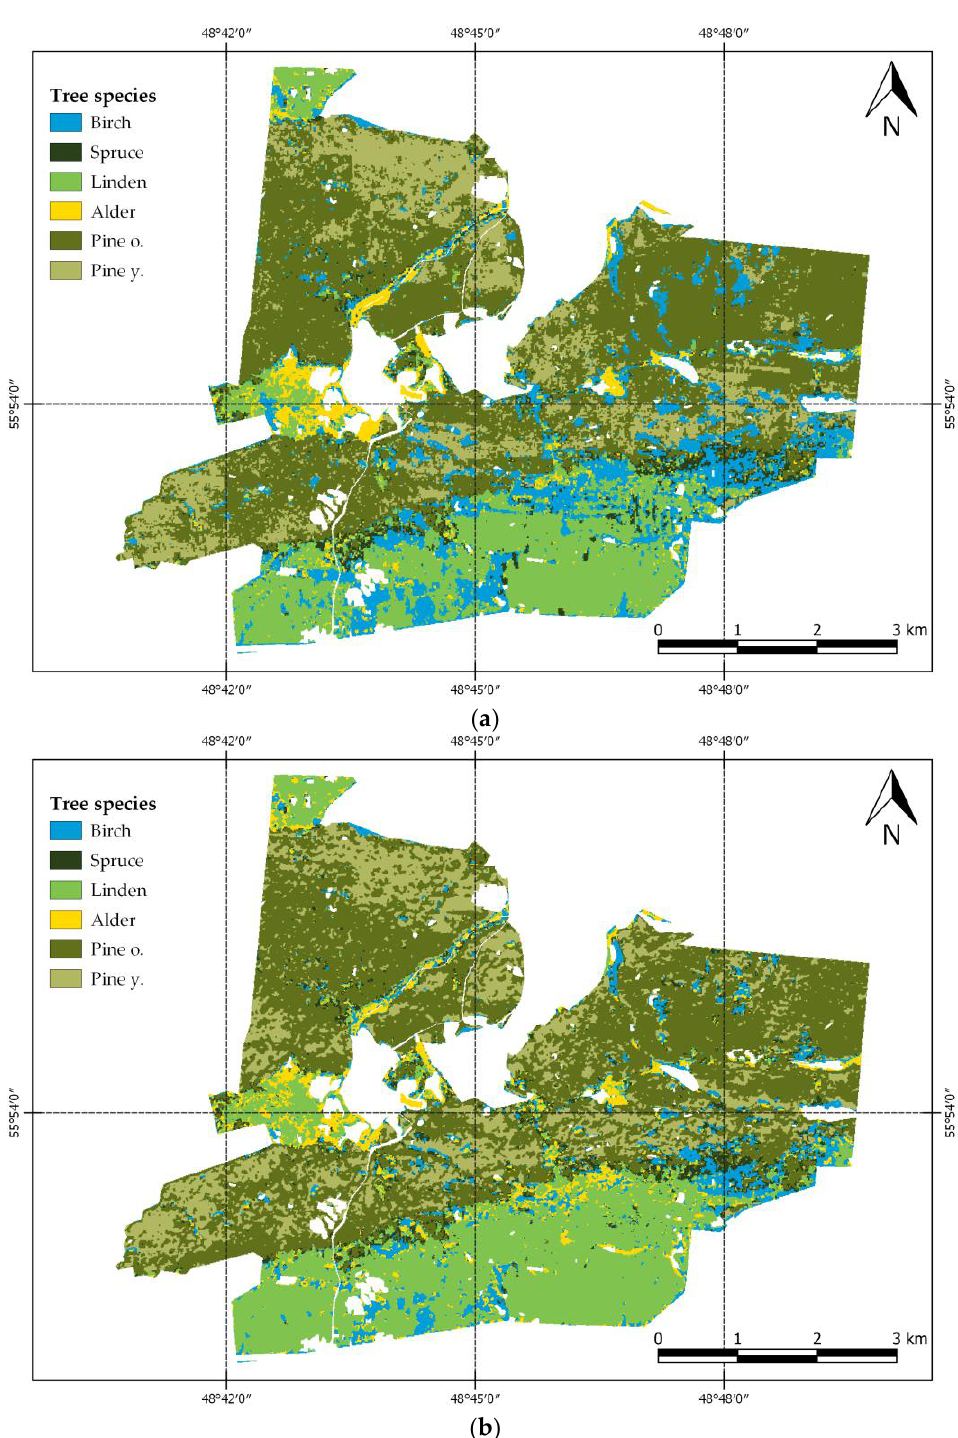
Figure 6. Sentinel-2 data classification results: ( a ) RF method; ( b ) GTM method.